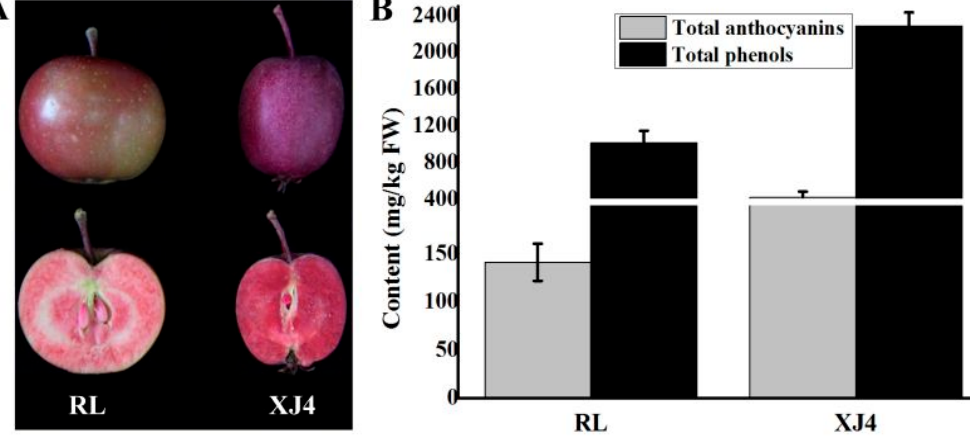
Figure 1. The phenotype, total anthocyanins, and phenols content of two different types of red ‐ fleshed apples. ( A ) Intact and longitudinal section of Red Laiyang (RL) and Xinjing No.4 (XJ4); ( B ) total anthocyanins and phenols content of RL and XJ4.